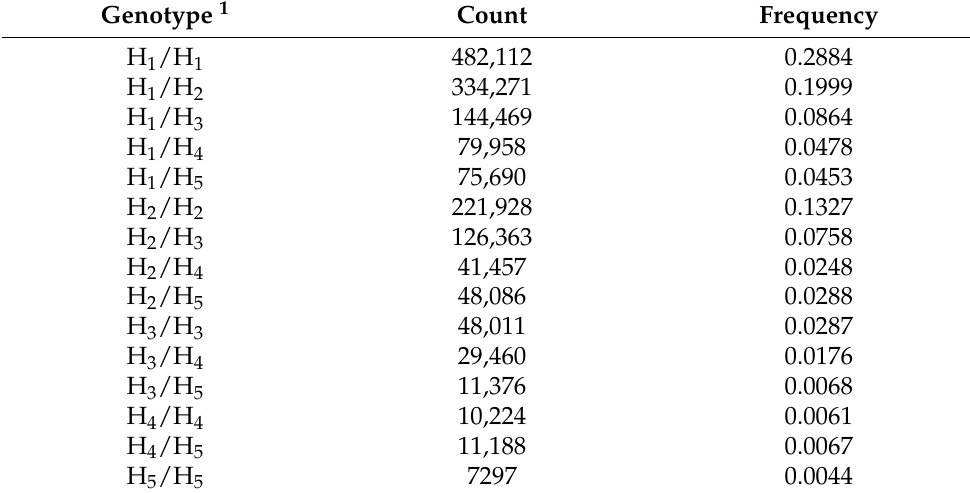
Table 2. Genotype count and frequencies in the